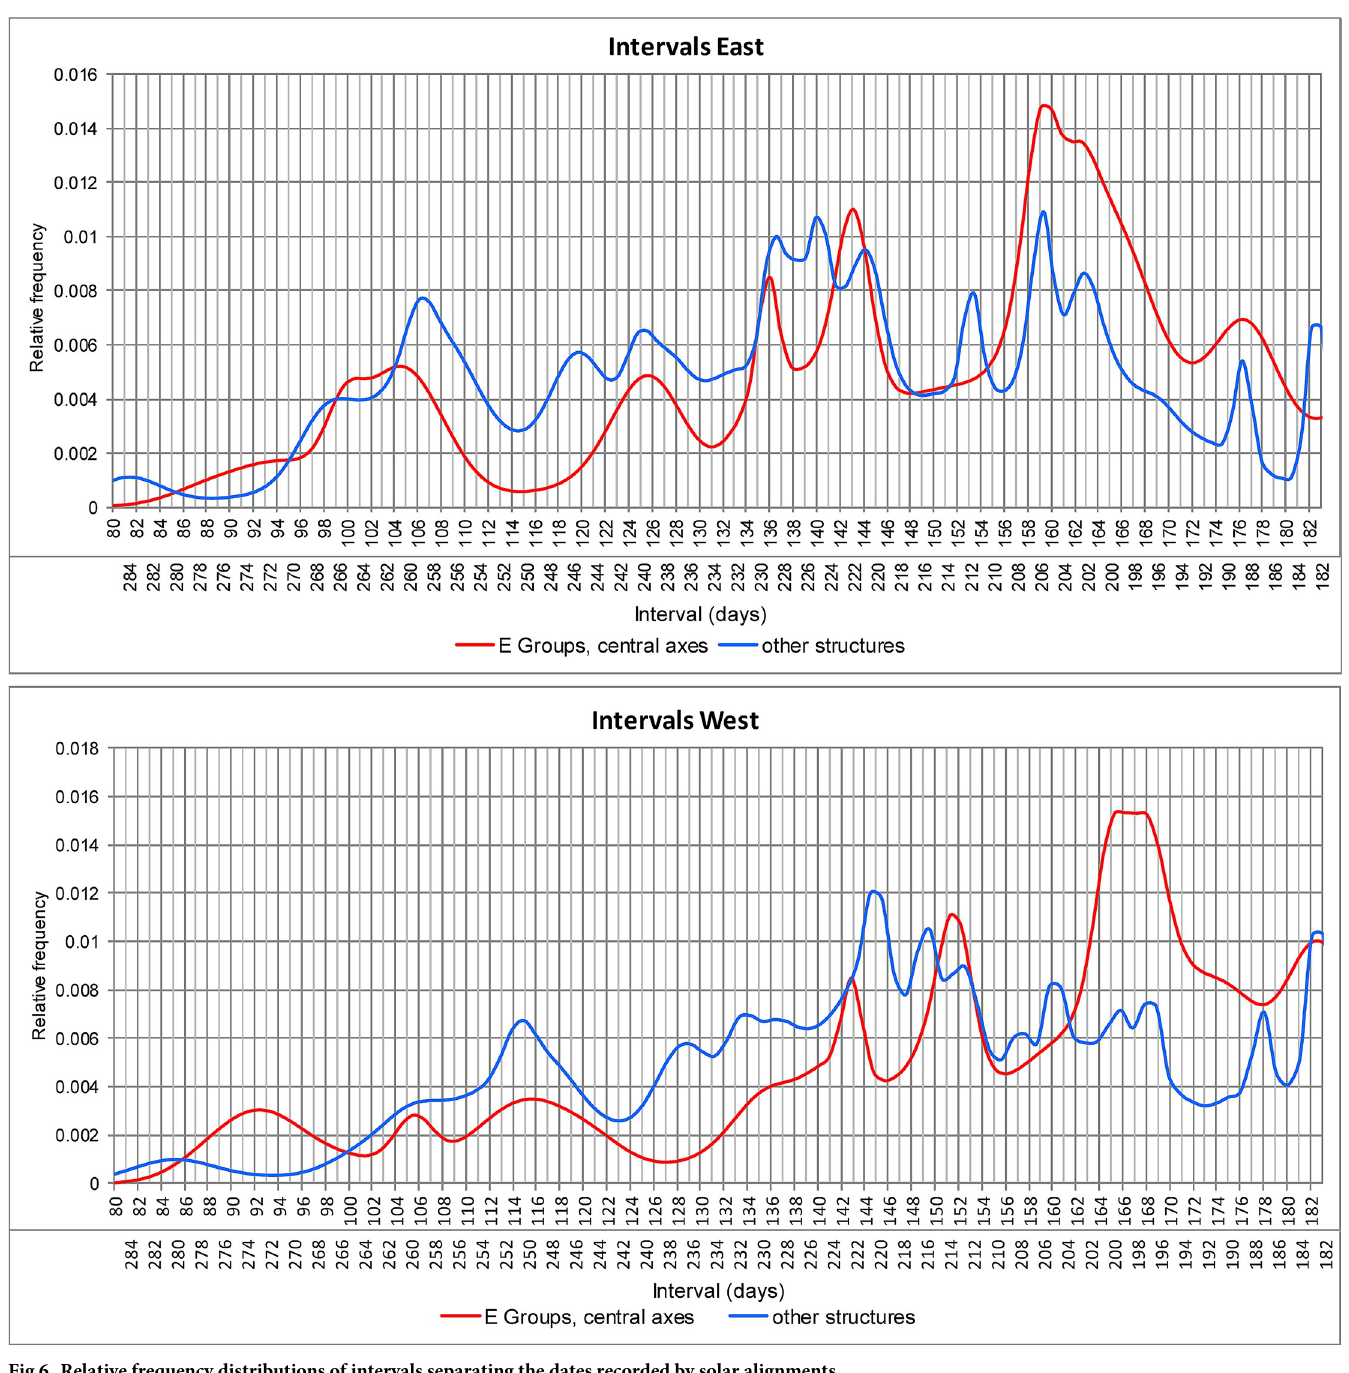
Fig 6. Relative frequency distributions of intervals separating the dates recorded by solar